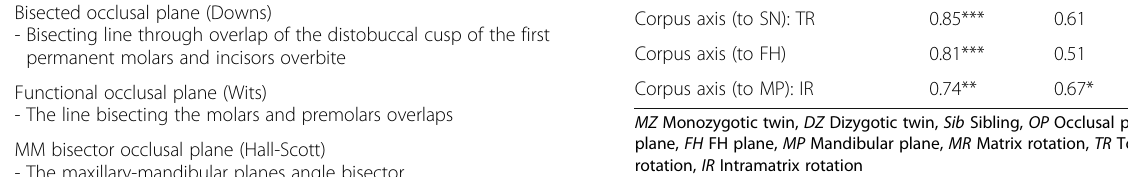
Table 2 Three occlusal planes Bisected occlusal plane (Downs) - Bisecting line through overlap of the distobuccal cusp of the first permanent molars and incisors overbite Functional occlusal plane (Wits) - The line bisecting the molars and premolars overlaps MM bisector occlusal plane (Hall-Scott) - The maxillary-mandibular planes angle bisector